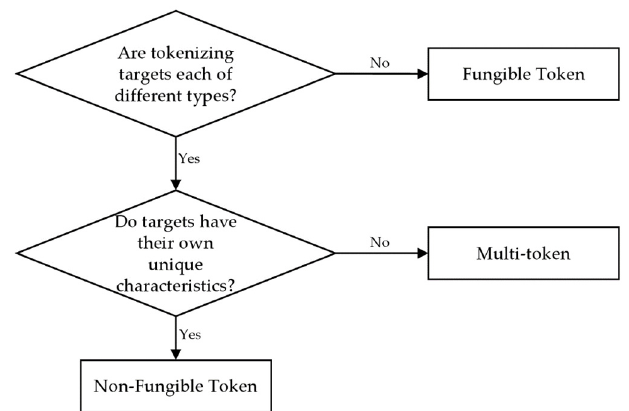
Figure 7. Checklist when selecting token standards.